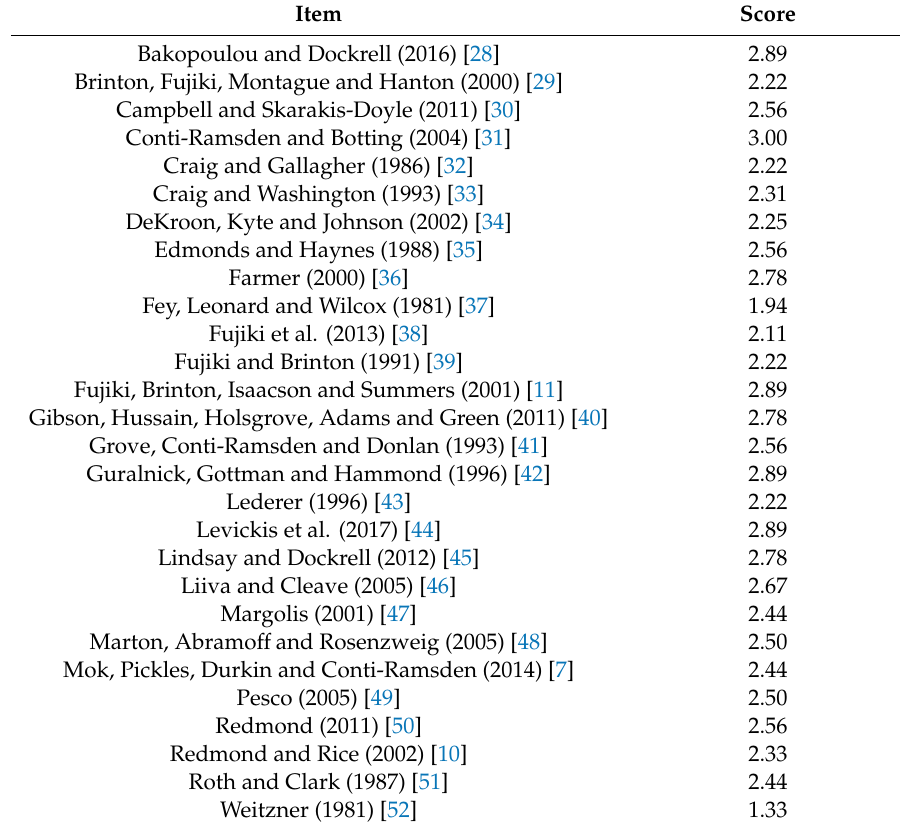
Table A3. Table to Show Quality Appraisal Scores Assigned to Studies Included in Review.